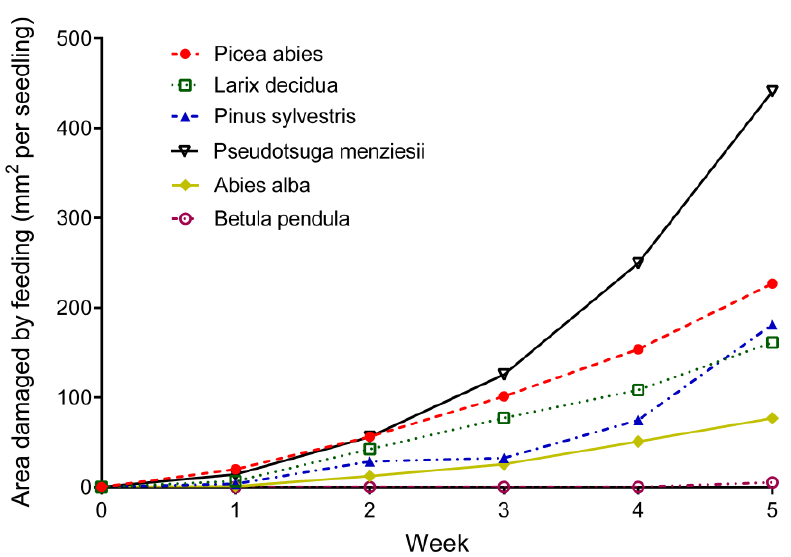
Figure 1. Cumulative mean weekly changes in feeding damage by Hylobius abietis adults on seedlings of 6 different tree species.